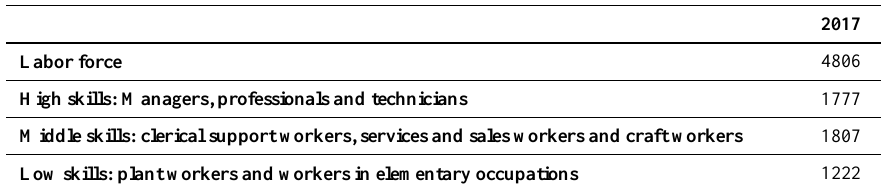
Table 5. Demand for knowledge